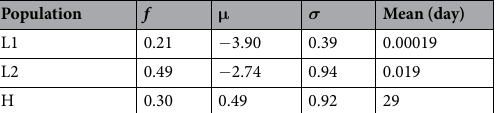
Table 1. Fraction ( f ), mean ( μ ) and standard deviation ( σ ) of the 3 lognormal inter-arrival times populations (Fig. 2b). The table reports also the estimated mean (expressed in day) of the correspondent not log